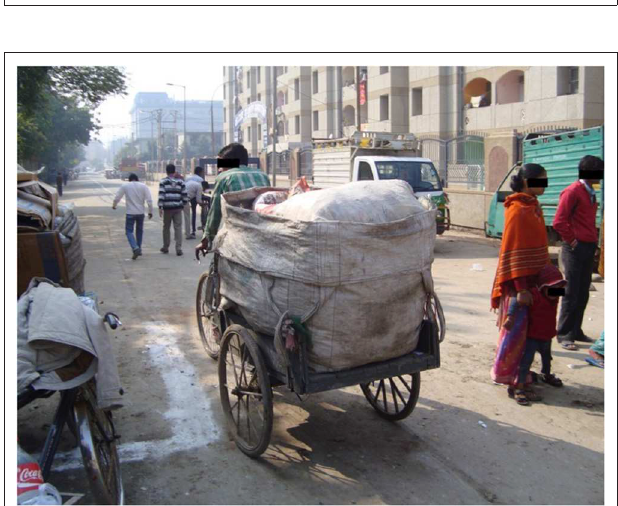
FIGURE 6 | The recyclable waste is transported by waste pickers to their “jhuggies” (huts).